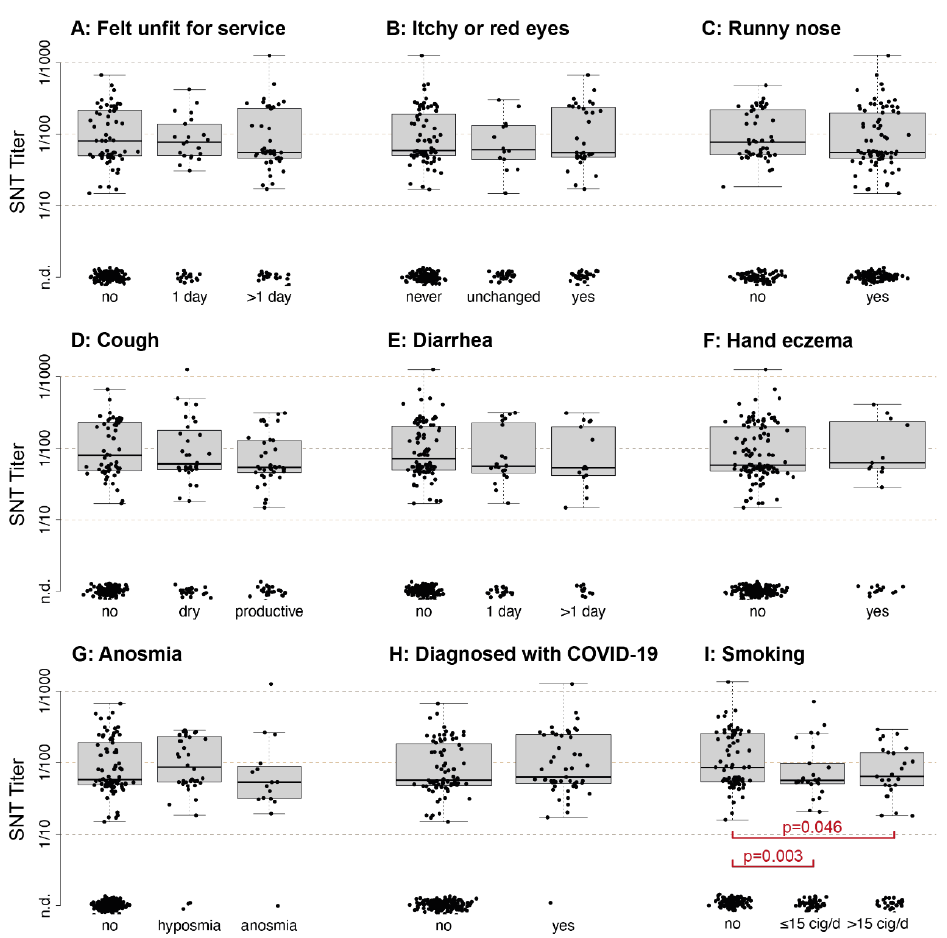
Figure 5. Correlation of symptoms and predisposing factors with the antibody response in young adults. Cross-sectional serum samples from 316 individuals were taken on the same day and neutralizing antibody titers were measured and plotted against self-declared symptoms experienced in the 30 days prior to sampling. Symptoms included general unfit feeling ( A ), itchy or red eyes ( B ), runny nose ( C ), cough ( D ), diarrhea ( E ), hand eczema ( F ), hyposmia or anosmia ( G ). Additionally, no differences in titers could be seen between the symptomatically and asymptomatically infected ( H ). ( I ) shows titers of individuals grouped by their smoking status: Individuals that smoked and produced nAbs showed significantly decreased titers as compared to non-smokers. Statistical significance was determined with the Wilcoxon rank sum test. p -values < 0.05 were considered statistically significant. n.d. = not detected. Table 1. Symptoms of infection with